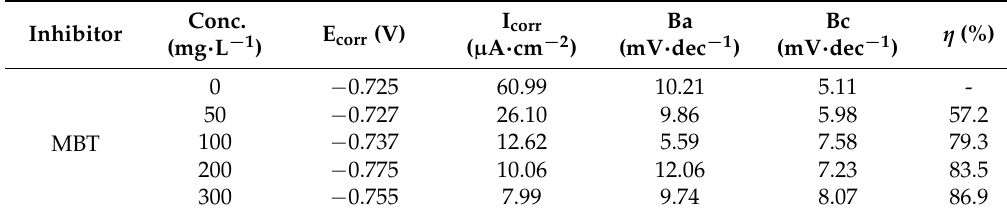
Table 3. Electrochemical parameters of different MBT